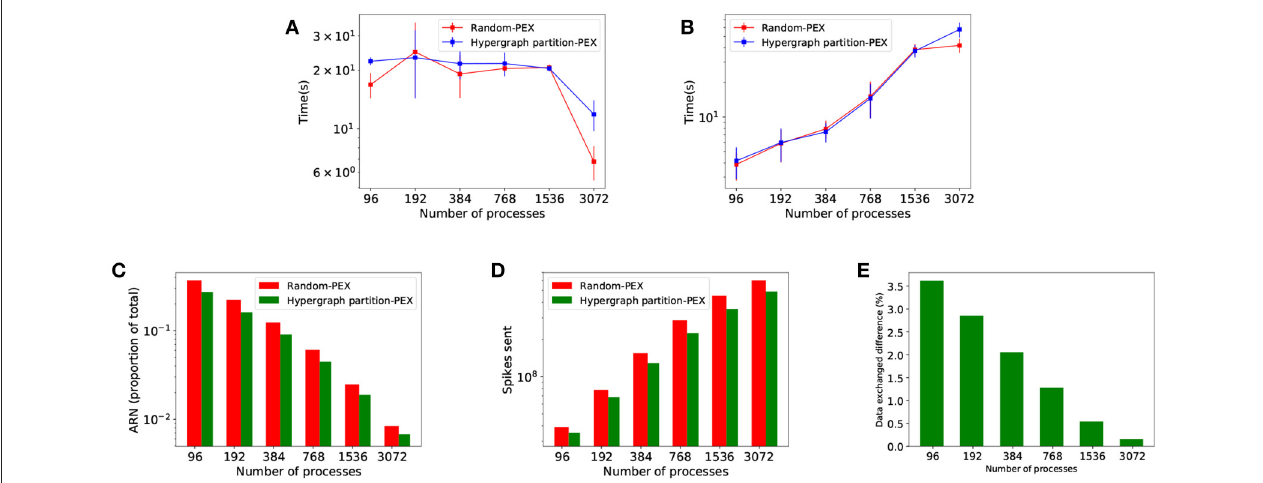
FIGURE 7 | Performance results of Random balanced allocation compared with hypergraph partitioning . The top part shows quantitative timings during the different phases of communication: (A) Implicit synchronization time and (B) data exchange time. The bottom part of the figure shows reductions brought by hypergraph partitioning over random: (C) Average number of runtime neighbors (average number of processes each process communicates to at any given communication step, a subset of the total neighborhood defined in the PCG); (D) remote spikes (local spikes that need to be propagated to other processes); (E) spiking data volume exchanged difference.